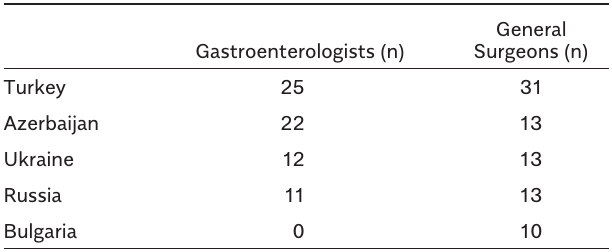
Supplementary Table 4. Demographic Characteristics of the Survey